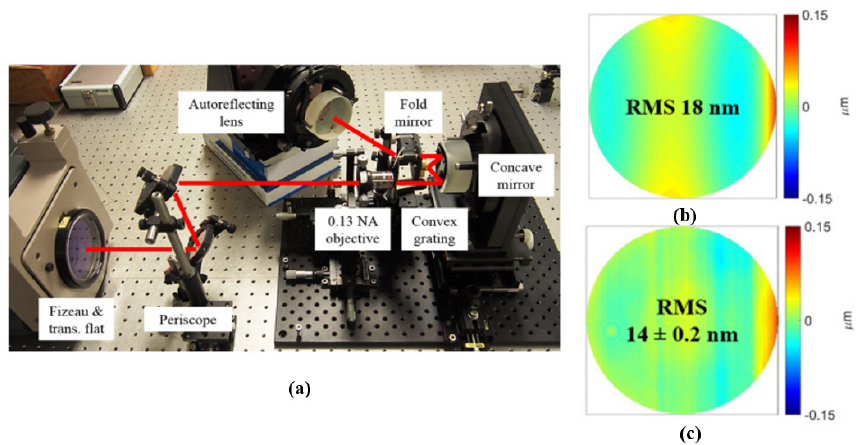
Figure 13. ( a ) Experimental setup for nulling interference test coupled to a phase-shifted Fizeau interferometer. ( b ) Designed expected nulling wavefront. ( c ) An example of the nulling wavefront obtained in the experiment [62].